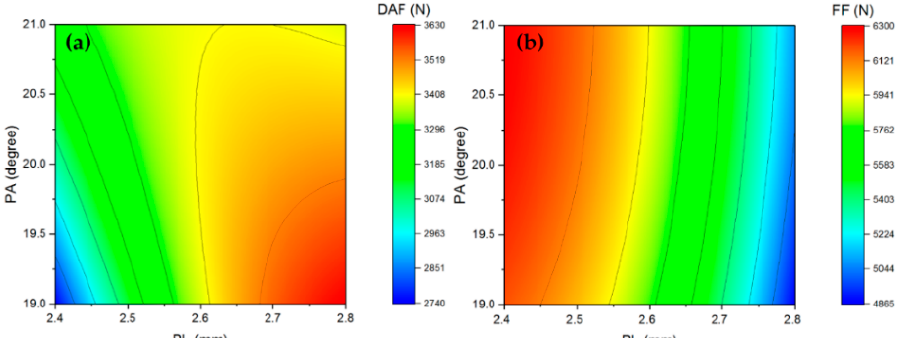
Figure 8. Contour plots of: ( a ) The downward axial force during the RAFSW process; ( b ) Failure force at a tensile shear test versus pin length ( PL ), and pin angle ( PA ) while other geometry and process parameters are the same as parameters of sample No. 21 except for the plunge depth, which is the same as the pin length. The contour plots were extracted from developed ANN models in this paper.